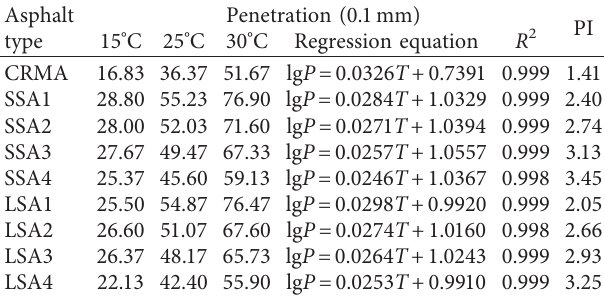
Figure 2: Dynamic shear rheometer (DSR). Table 2: Penetration test results of asphalt